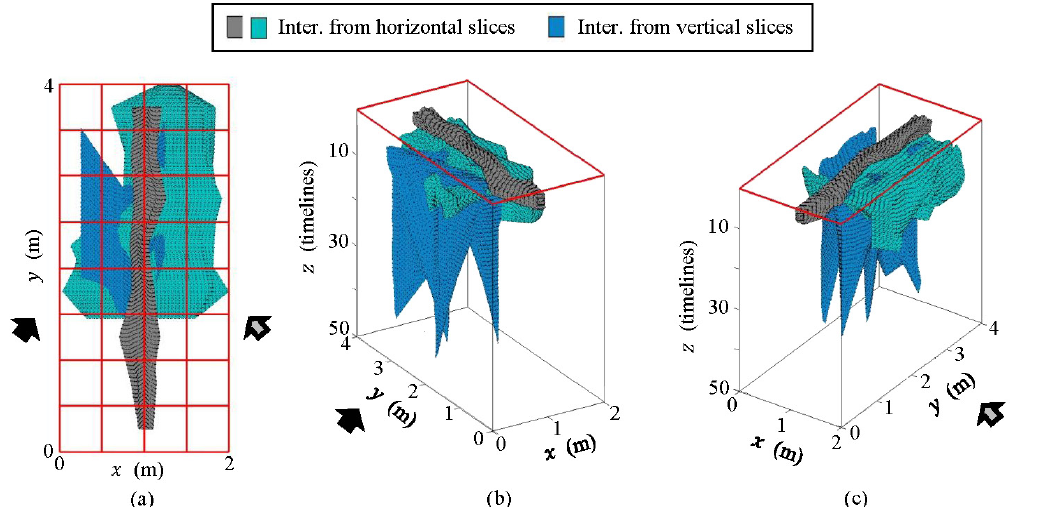
Figure 26. Interpretation from pre-processed images: 3D model. ( a ) azimuthal view; ( b ) lateral view #1; ( c ) lateral view